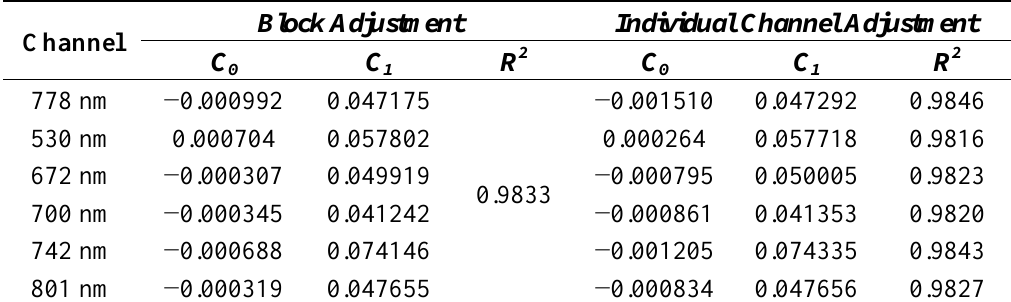
Table 5. Mini-MCA calibration coefficients.